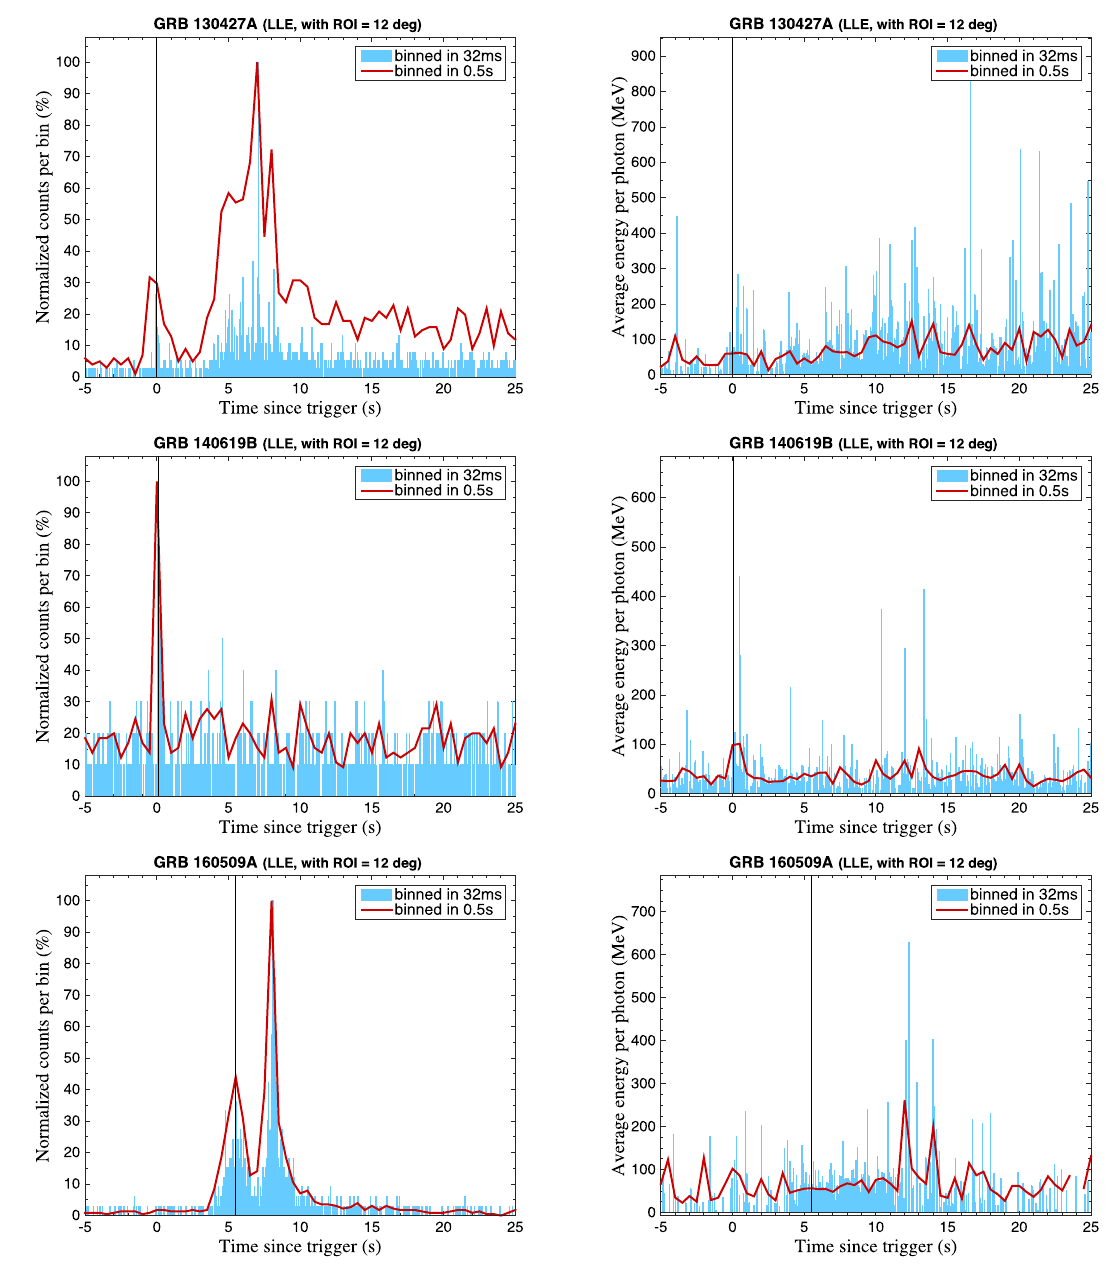
Fig. 22 Curves in Set-LLE (part 2): light curves and average energy curves of LLE data